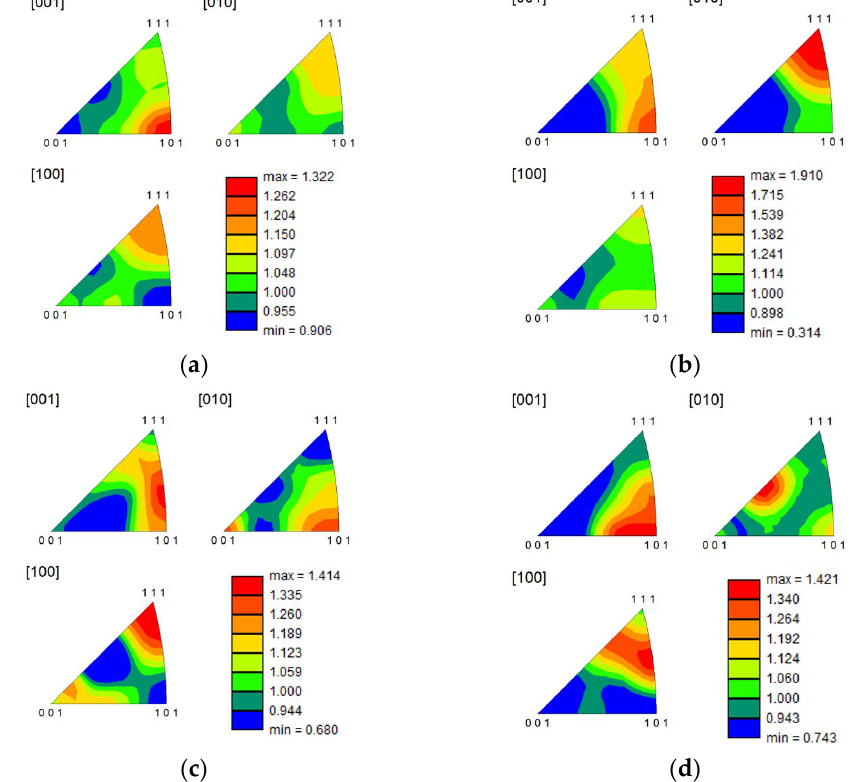
Figure 7. Inverse pole figure (IPF) of ( a ) Ni heat-treated at 700 °C for 120 min, ( b ) Ni-1.00 vol.% CNT heat-treated at 700 °C for 120 min, ( c ) Ni heat-treated at 1100 °C for 30 min and ( d ) Ni-1.00 vol.% CNT heat-treated at 1100 °C for 30 min.